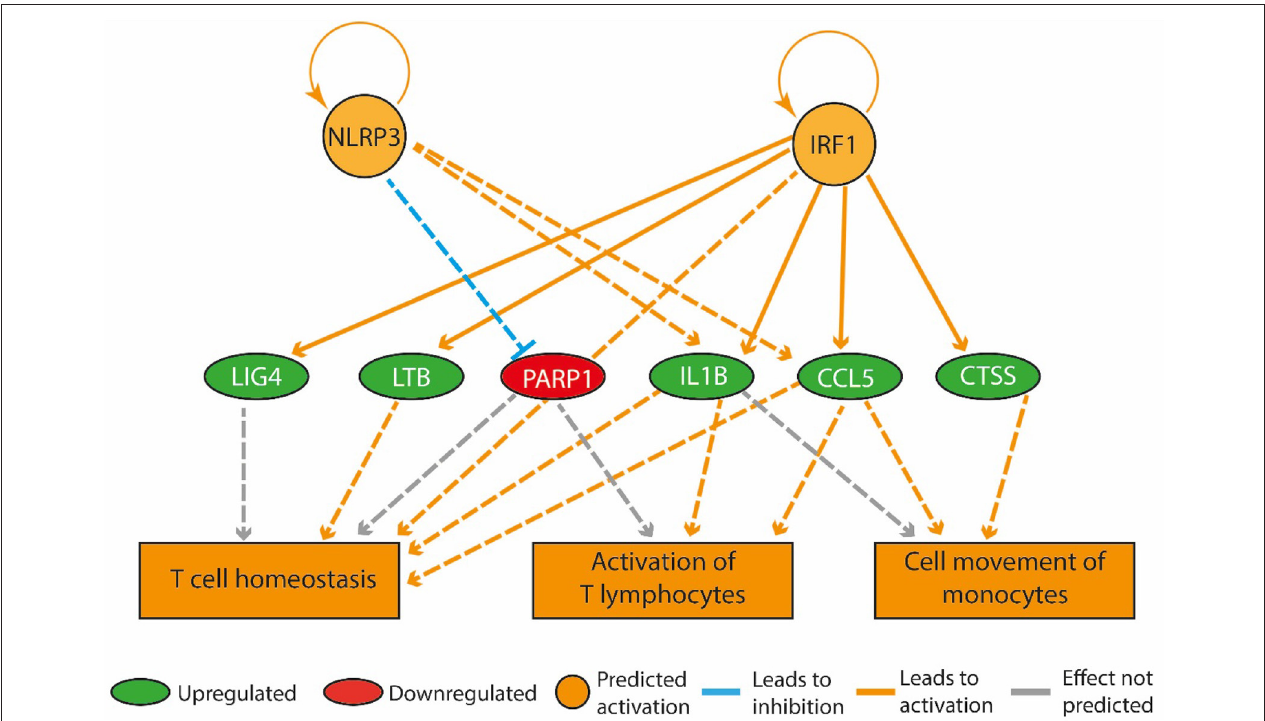
FIGURE 3 | A high-fat diet in early life upregulated genes that promote inflammation in the bone marrow. The regulatory network pictured consists of three tiers. The top tier consists of predicted upstream regulators that might explain the gene expression changes observed in the experiment. NLRP3 and IRF1 are the upstream regulators whose predicted activated state may explain the expression changes in LIG4, LTB, PARP1, IL1B, CCL5, and CTSS (middle tier). The observed upregulation of LIG4, LTB, IL1B, CCL5, and CTSS and the downregulation of PARP1 leads to a predicted increase in T cell homeostasis, activation of T lymphocytes and cell movement of monocytes (bottom